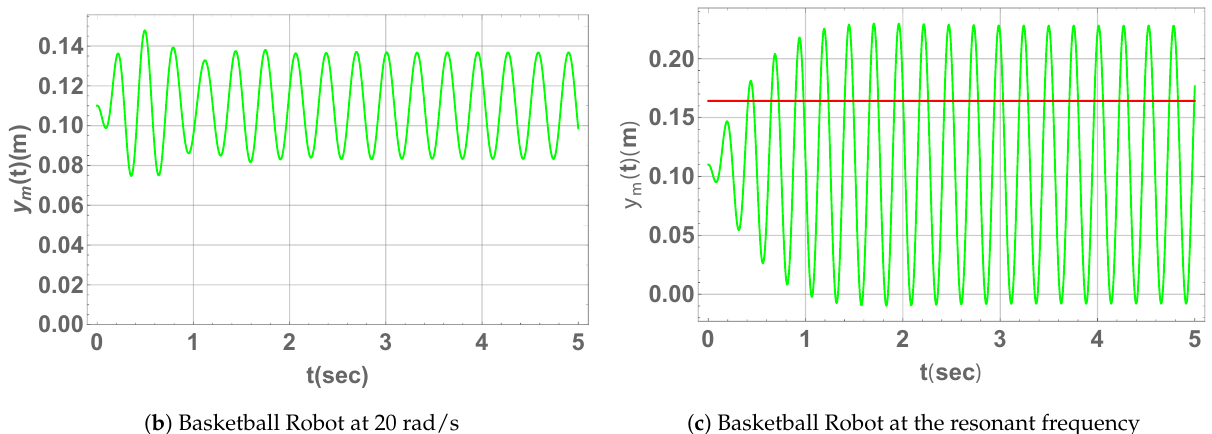
( c ) Basketball Robot at the resonant frequency Figure 8. Attached to ground, Basketball Robot